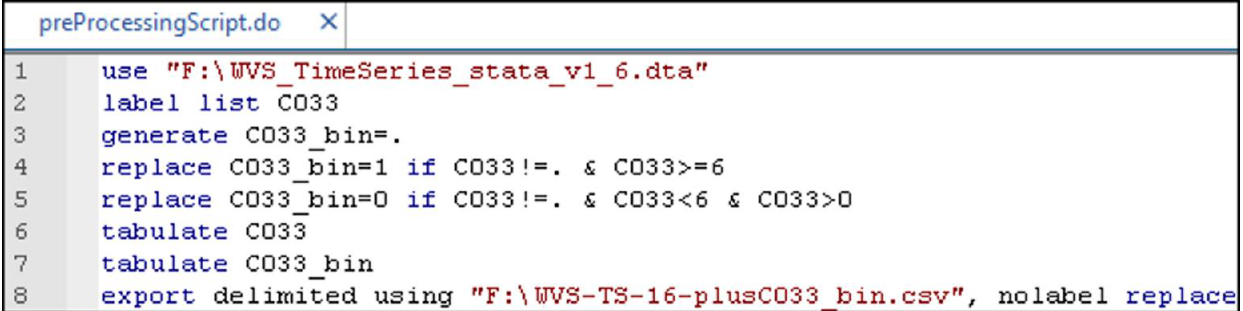
Figure 1. Stata script used for generating and checking the values of the binary alternative of the outcome (C033_bin) and exporting the dataset as.csv using numeric values instead of labels.